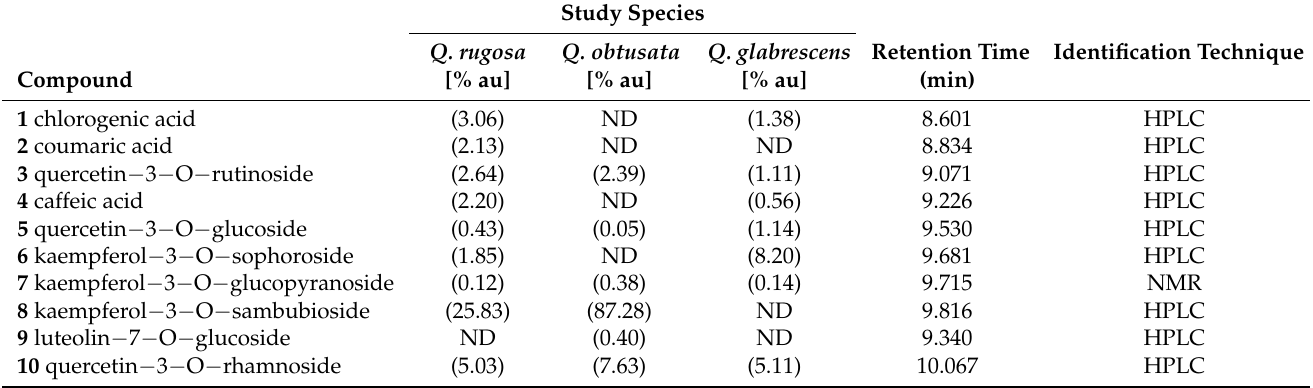
Table 1. Comparison of phenolic compounds ( 1–16 ) identified in Q. rugosa , Q. obtusata